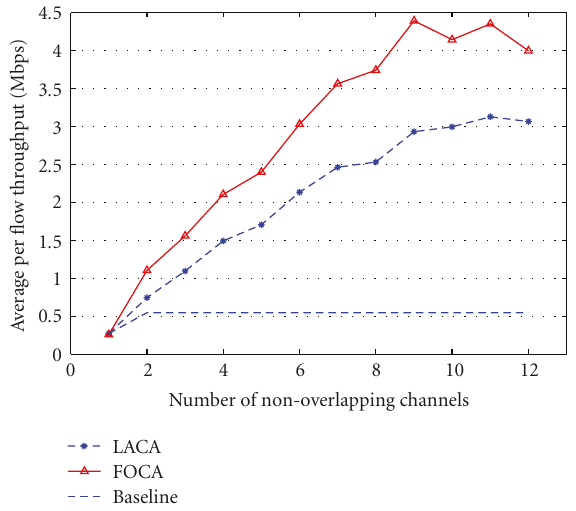
Figure 8: Compare FOCA and LACA in multi-channel 2-radio random networks with three 5-hop flows.